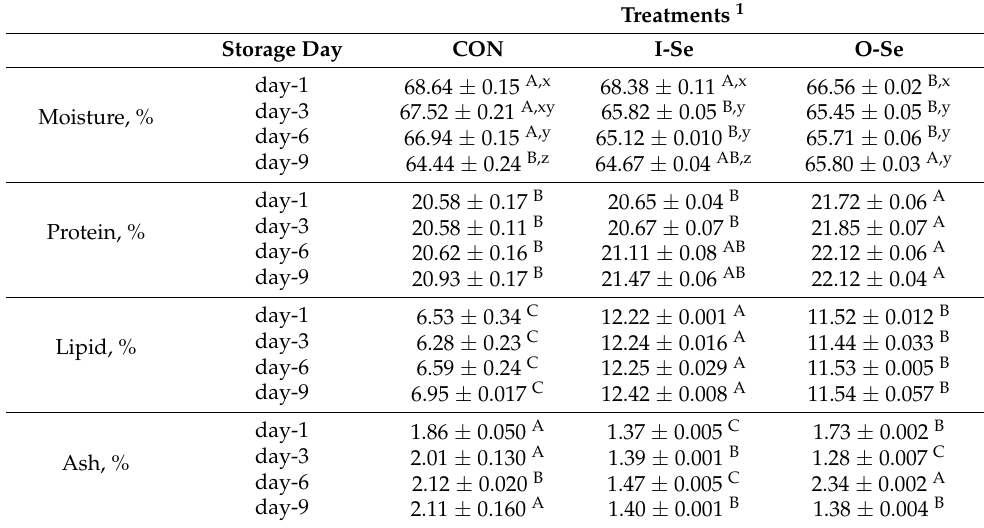
Table 2. Effects of dietary supplementation with inorganic or organic selenium on the chemical composition for goose meat (equal portions of the breast and thigh meat) of native Azerbaijan